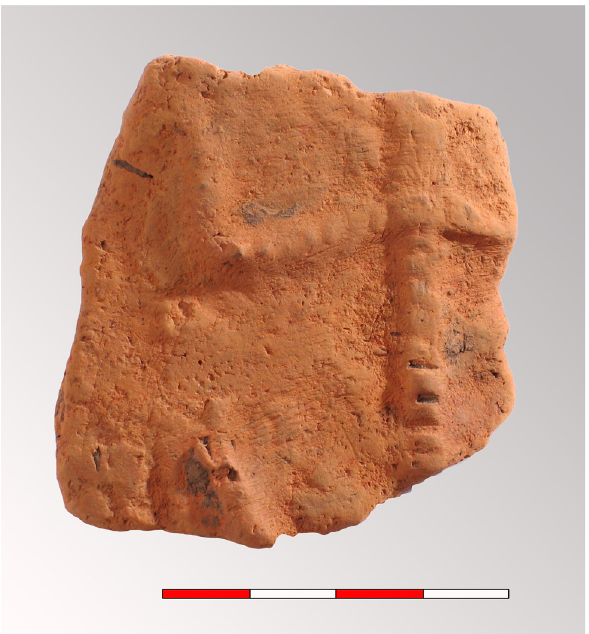
Figure 9: Fragment of amphora with anthropomorphic representation from Targowisko site 14 – 15 ( acc. to Czerniak et al., 2007 )